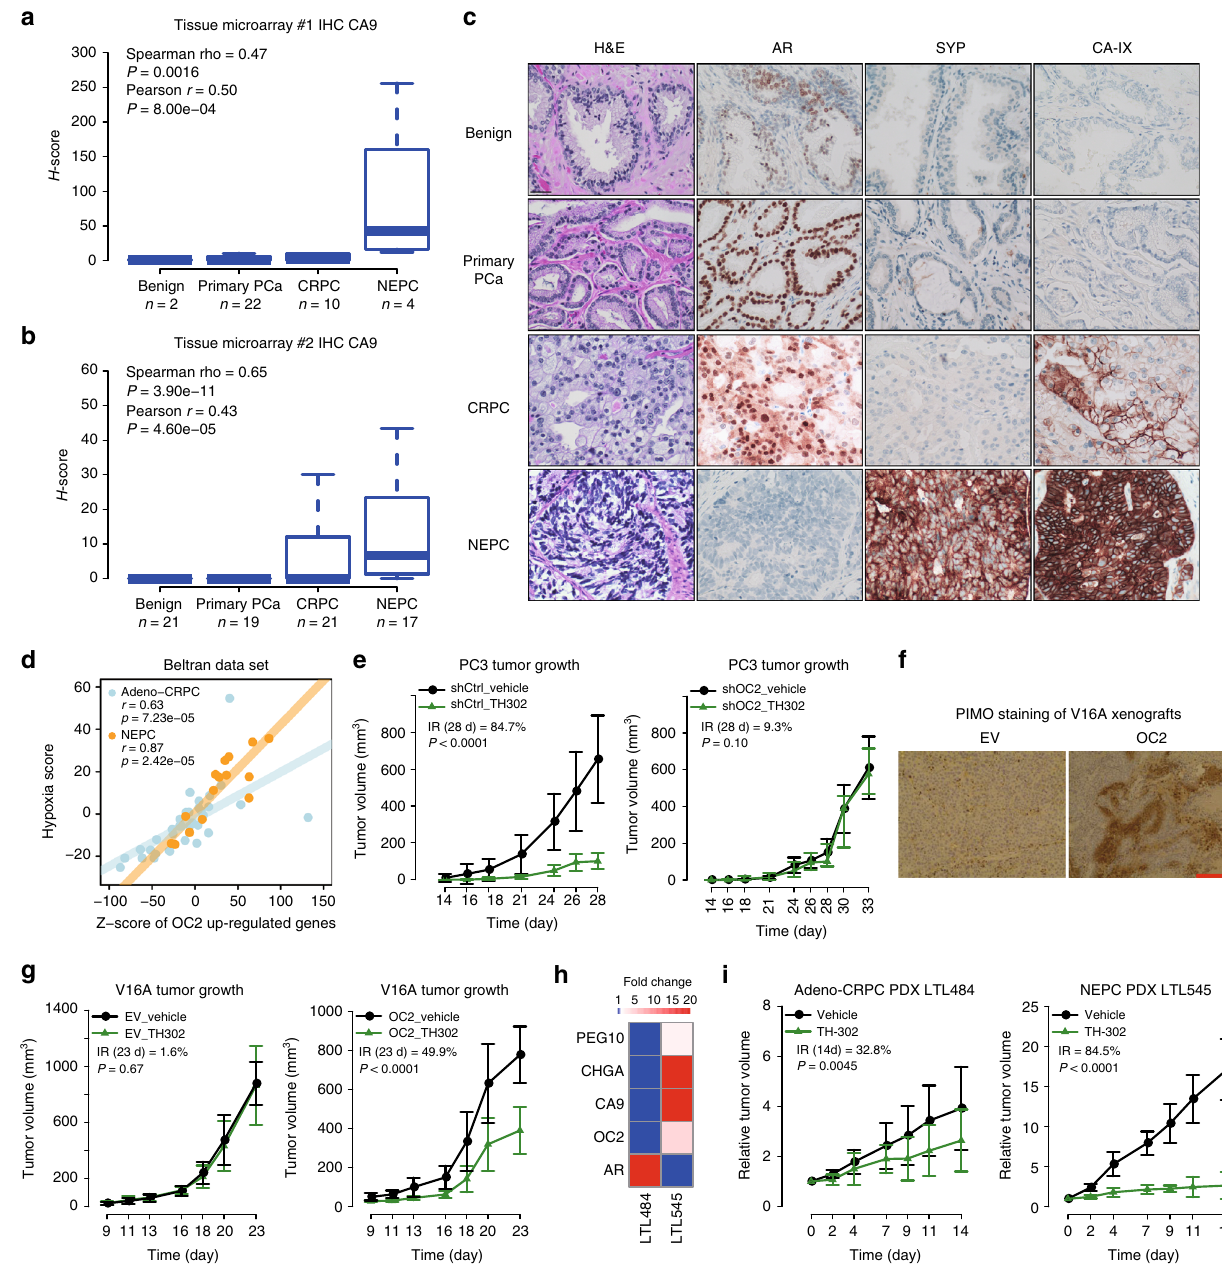
Fig. 5 NEPC is highly hypoxic and sensitive to hypoxia-directed treatment. a , b Hypoxia marker gene CA9 IHC staining in two independent tissue microarray sets. The combined H-score, taking into account of both staining intensity and percentage, was used to quantify CA9 protein levels. (c) Representative images of tissue microarray analysis of AR, SYP, and CA9 IHC staining in benign prostate, primary PCa, adeno-CRPC, and NEPC tissues. Scale bar = 50 μ m. d Correlation between ONECUT2 upregulated genes (summarized in z -scores) and hypoxia scores in Beltran adeno-CRPC/NEPC dataset. e PC3 xenograft tumor growth in response to hypoxia-activated prodrug TH-302 treatment, with and without silencing of ONECUT2. n = 7 for shCtrl_Vehicle; n = 6 for shCtrl_TH302; n = 8 for shOC2_Vehicle; n = 7 for shOC2_TH302. f Representative images of PIMO IHC staining of V16A xenograft tumors with and without overexpression of ONECUT2. Scale bar = 200 μ m. g V16A xenograft tumor growth in response to TH-302 with and without overexpression of ONECUT2. n = 7 for EV_Vehicle; n = 8 for EV_TH302; n = 6 for OC2_Vehicle; n = 6 for OC2_TH302. h Relative expression levels of related genes in the adeno-CRPC (LTL484) and NEPC (LTL545) PDX models determined by microarray analysis. i TH-302 treatment suppresses tumor growth in NEPC patient-derived xenografts. n = 4 for vehicle group and n = 4 for TH-302 group in NEPC PDXs; n = 5 for vehicle group and n = 5 for TH-302 group in adeno-CRPC PDXs. In e , g , and i , inhibition rate (IR) of tumor growth was calculated as (Tumor volume Vehicle − Tumor volume TH-302 )/ Tumor volume Vehicle . P values were determined by mixed-effects models of repeated-measures ANOVA for e , g , and i . Source data are provided as a Source Data fi